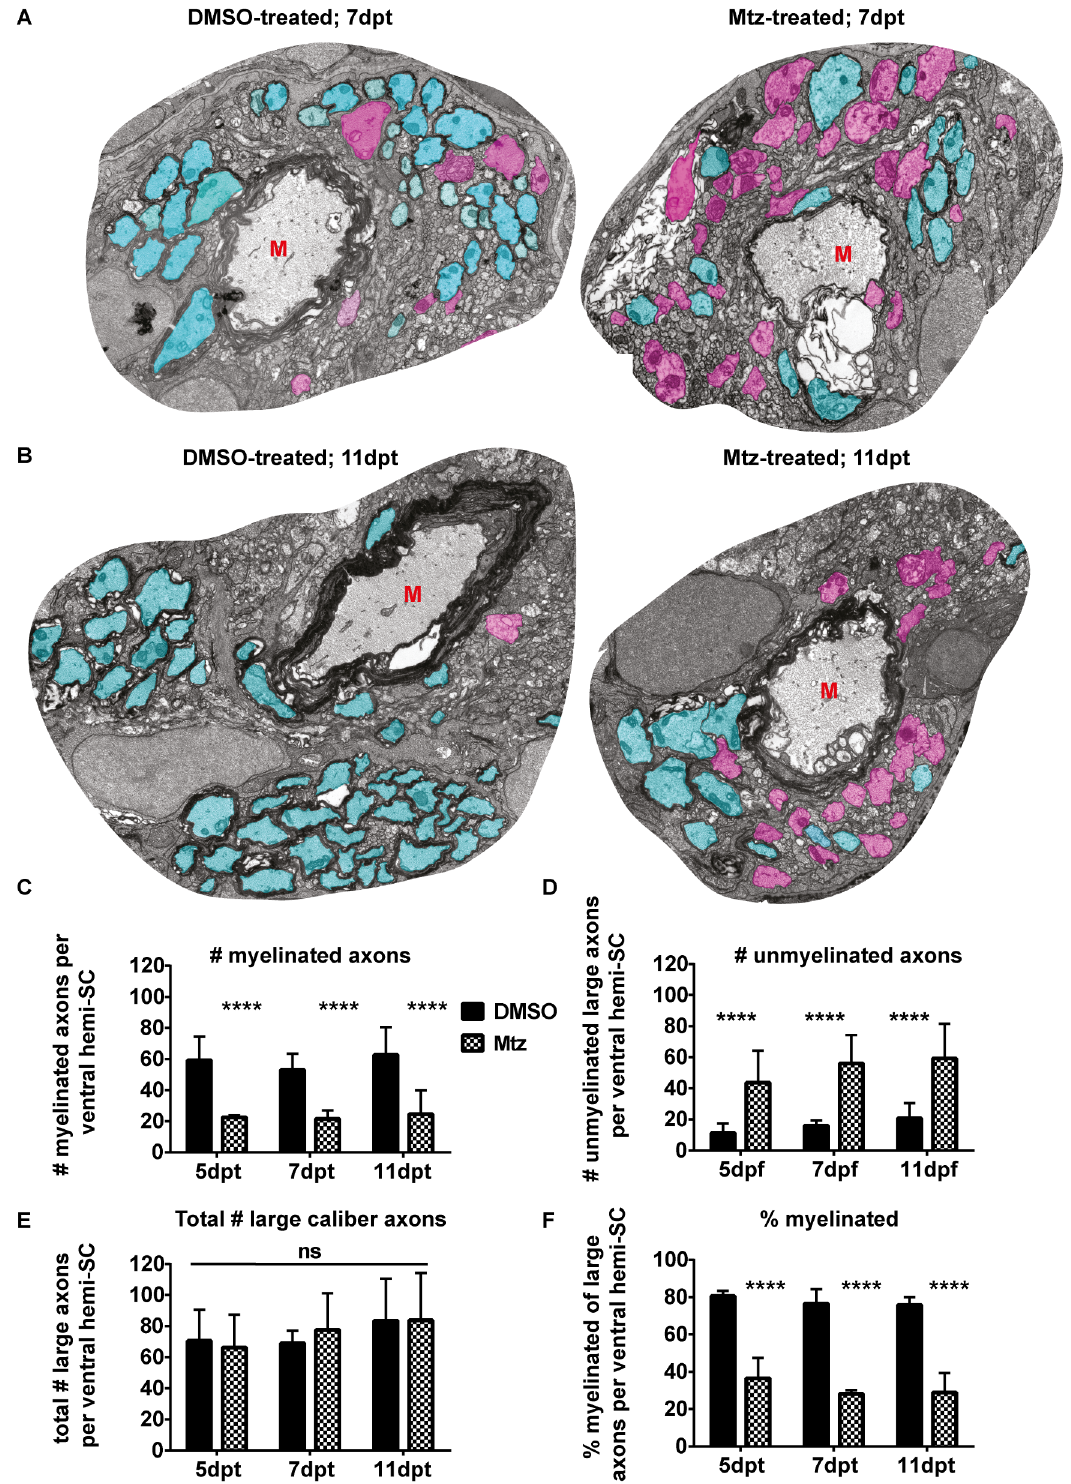
Fig 6. Oligodendrocyte ablation results in extensive demyelination of reticulospinal axons. A-B . Representative electronmicrographsof ventral hemi-spinal cords of DMSO- or Mtz-treated Tg(mbp:mCherry-NTR) larvae at 7dpt or 11dpt as indicated.Myelinatedaxons are shadedin turquoiseand non-myelinated axons in pink. Red letters M indicateMauthner axons. Scale bar: 1 μ m. C. Quantification of the number of myelinatedaxons per ventral hemi-spinal cord at 5, 7 and